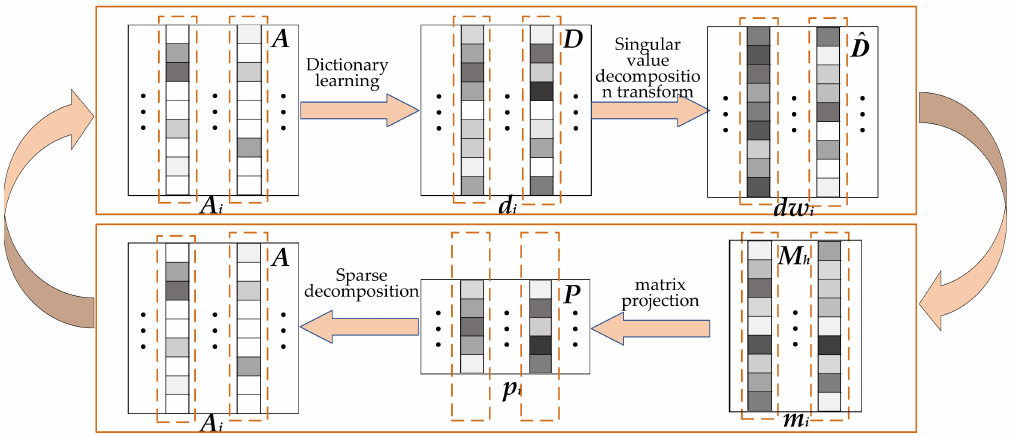
Figure 2. Block diagram of TIPML (task-driven invertible projection matrix learning algorithm). The specific implementation steps of the TIPML algorithm are shown in Algorithm